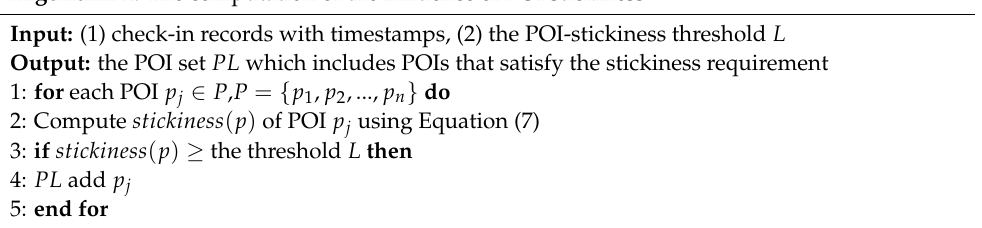
Algorithm 2. The computation of the influence of POI